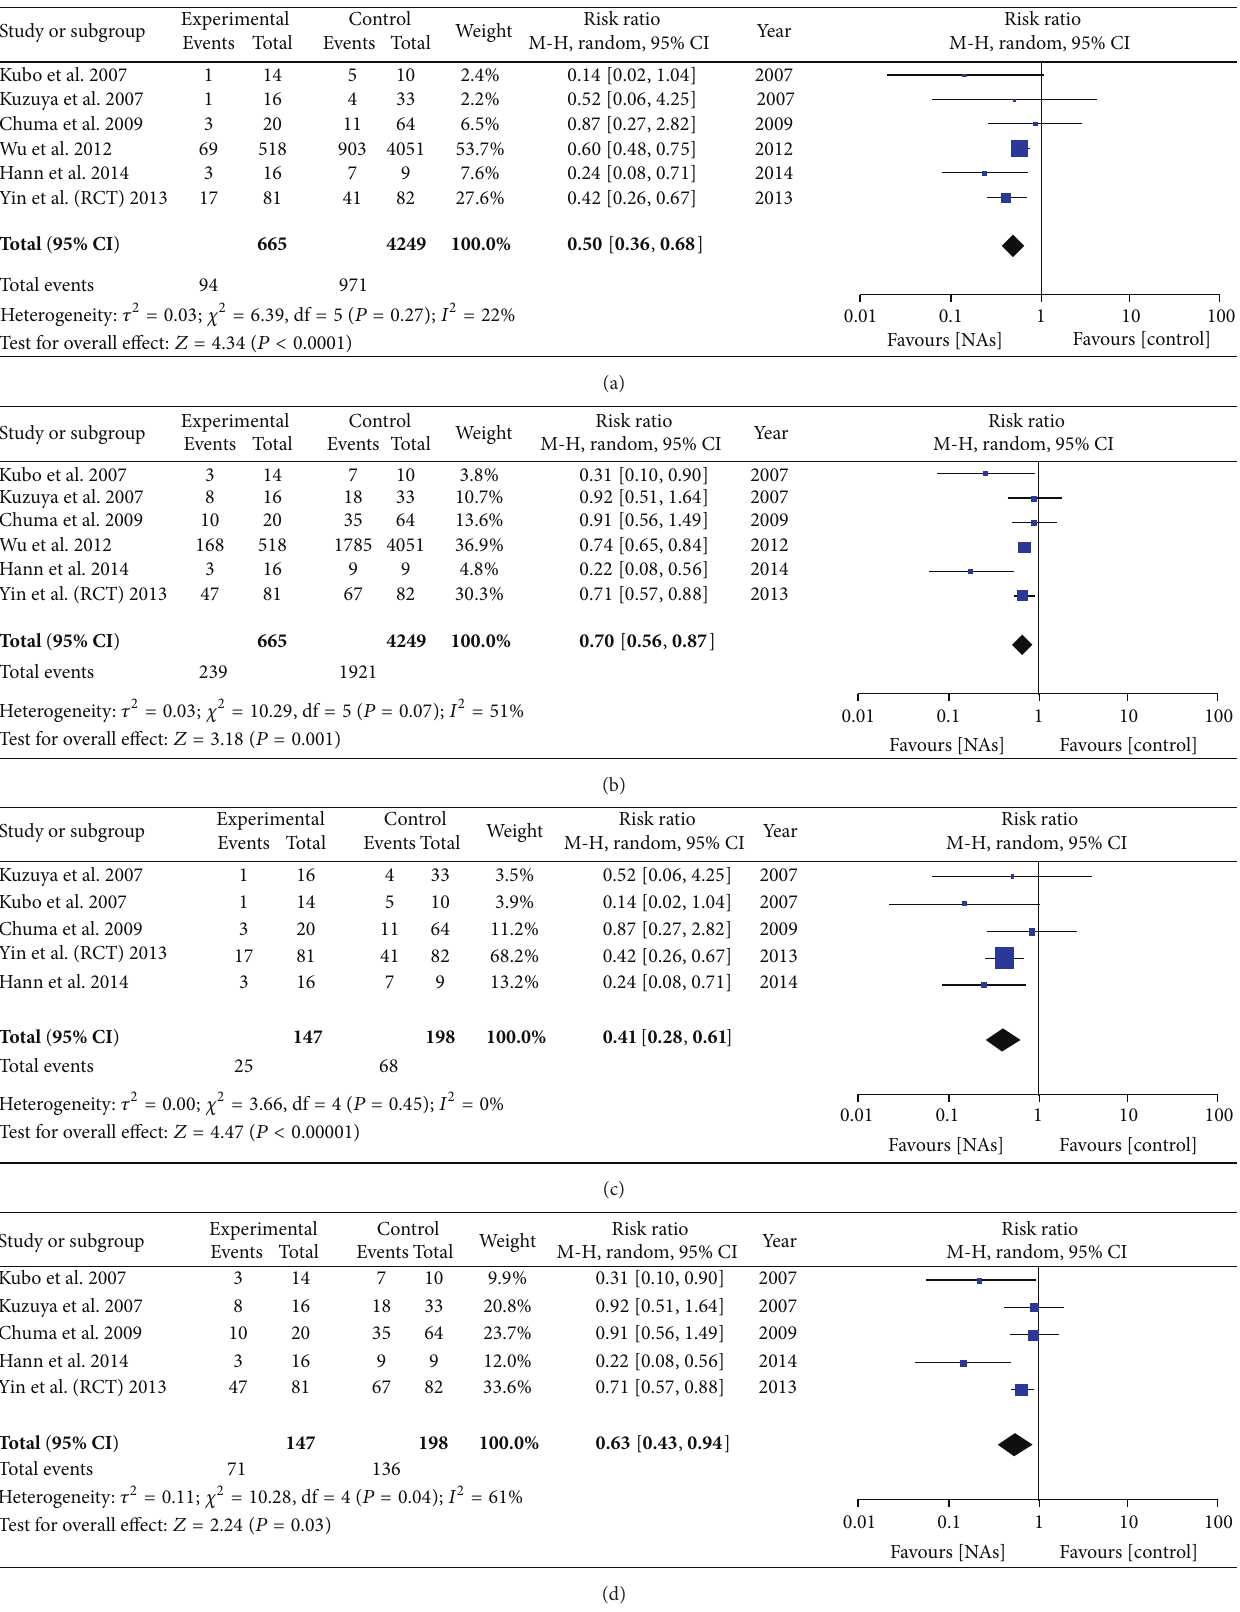
Figure 2: (a) Forest plot showing the impact of NAs on the 1-year recurrence rate without Wu et al.’s study. (b) Forest plot showing the impact of NAs on the 3-year recurrence rate without Wu et al.’s study. (c) Forest plot showing the impact of NAs on the 1-year recurrence rate with Wu et al.’s study. (d) Forest plot showing the impact of NAs on the 3-year recurrence rate with Wu et al.’s